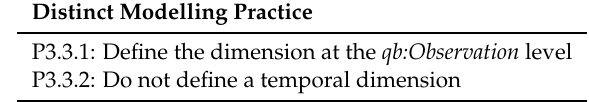
Table 33. Distinct modelling practices of data portals for defining dimensions with a single value in the structure of the data